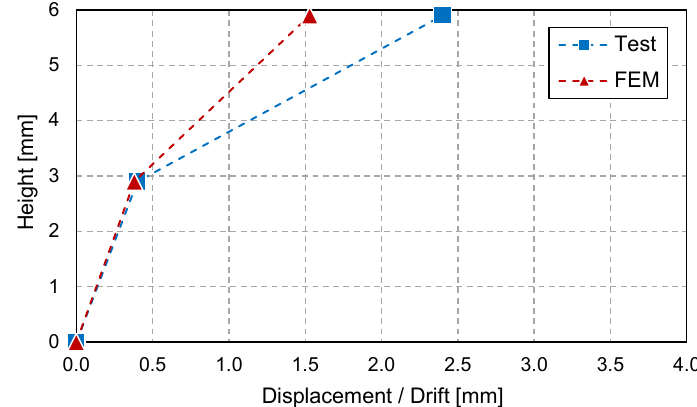
Figure 4. Comparison of the residual horizontal displacement/drift of the structure between the test [28] and the FE model. Positive values indicate horizontal displacement towards the removed column. Table 2. Comparison of the peak and residual values of maximum vertical displacement and drift between the test [28] and the FE model.